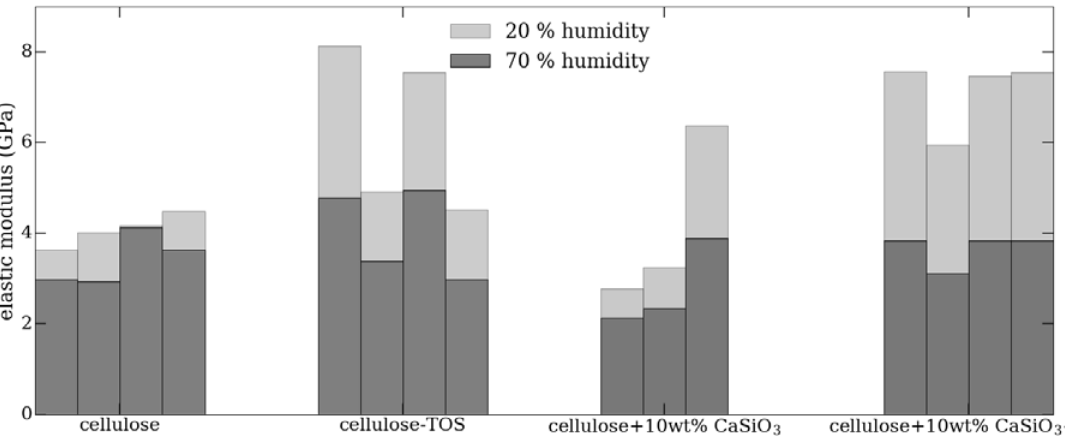
Figure 7. The elastic modulus of cellulose films with various treatments at 20% and 70% relative humidity (RH) (respectively light and dark grey). Each cellulose films were tested on 3 to 4 different films.